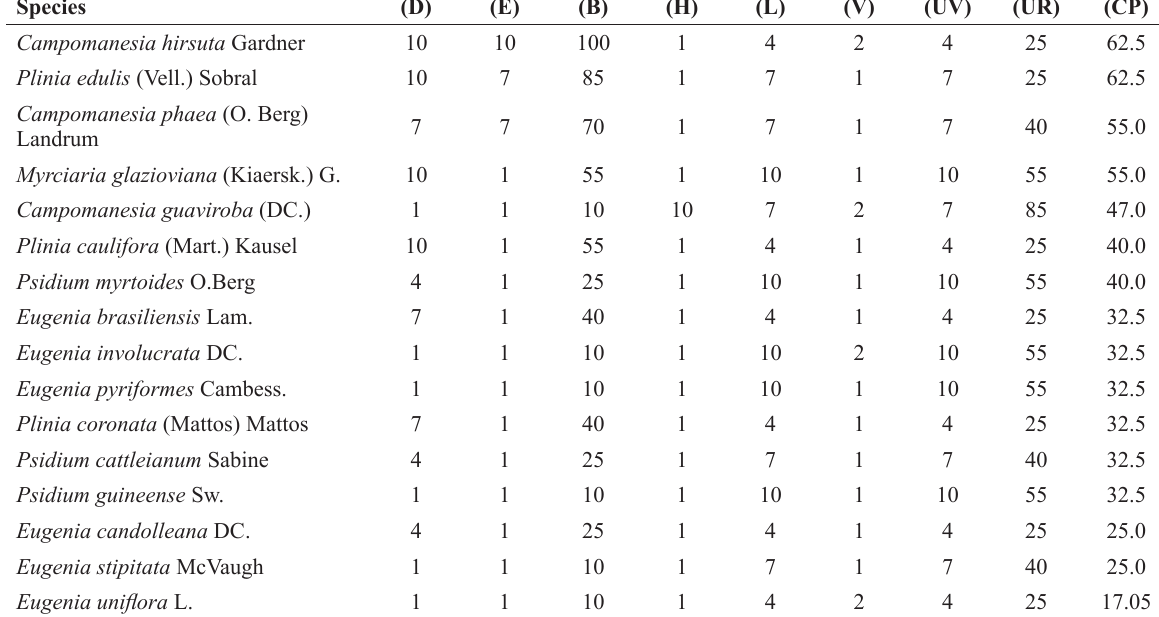
List of all native arboreal species of the Myrtaceae family used by rural dwellers of the mountain region of Espírito Santo, Brazil, in decreasing order of Conservation Priority, followed by the score of conservation priority criteria: Distribution (D), Extinction risk (E), Biological value (B), Harvesting risk (H), Local use (L), Use diversity (V), Use Value (UV), Use Risk (UR), and Conservation Priority